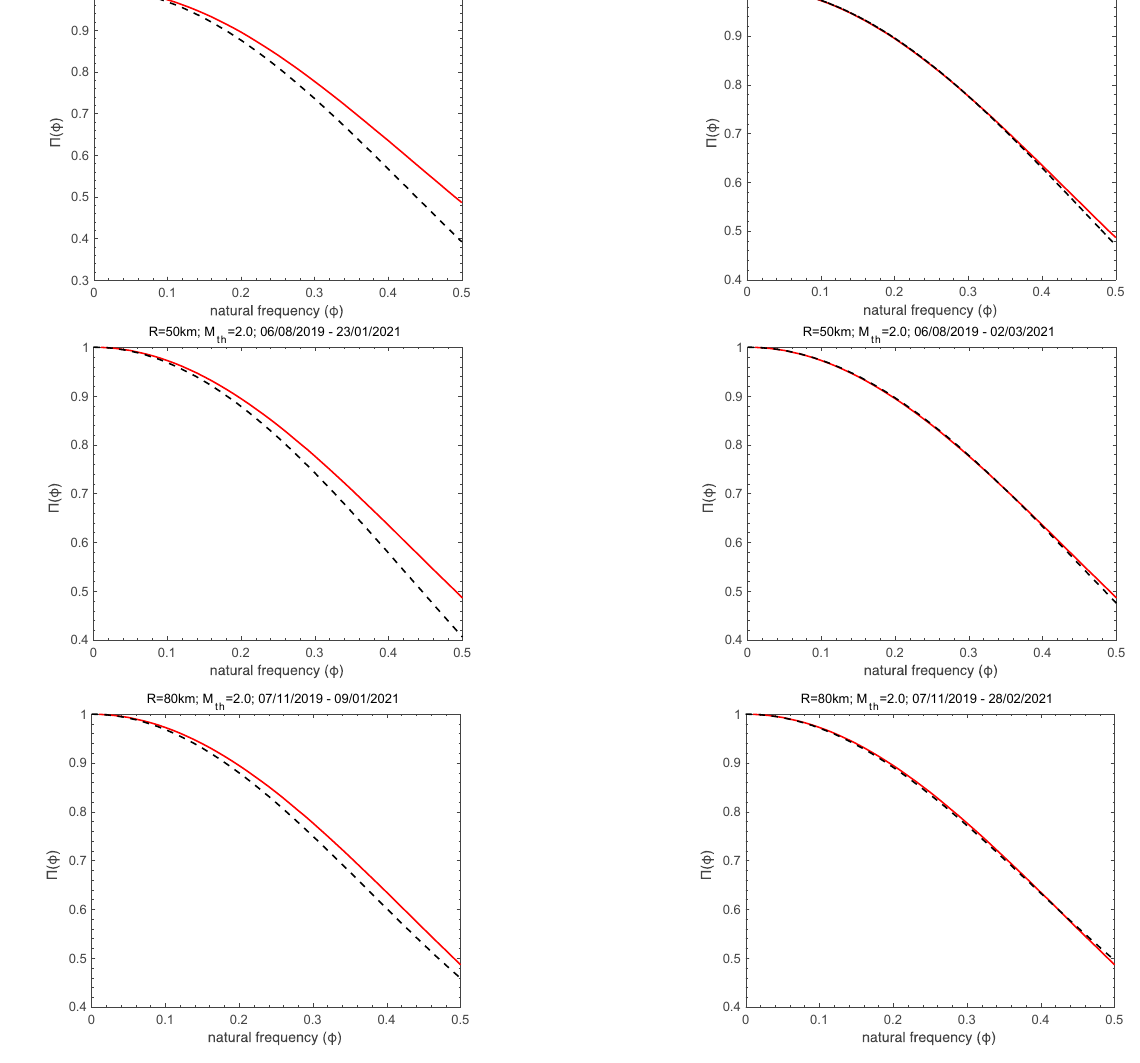
Figure 7. Time evolution of Π ( φ ), for 0 ≤ φ ≤ 0.5, of the seismic activity, for M th ≥ 2.0 and R = 30 km ( top ), R = 50 km ( middle ), and R = 80 km ( bottom ), when calculations start on 6 August 2019 for R = 30 km and R = 50 km and on 7 November 2019 for R = 80 km. Π ( φ ) curves (dashed lines) fall on the theoretical Π ( φ ) curve (red solid lines), calculated from Equation (6), as the critical stage is approached.